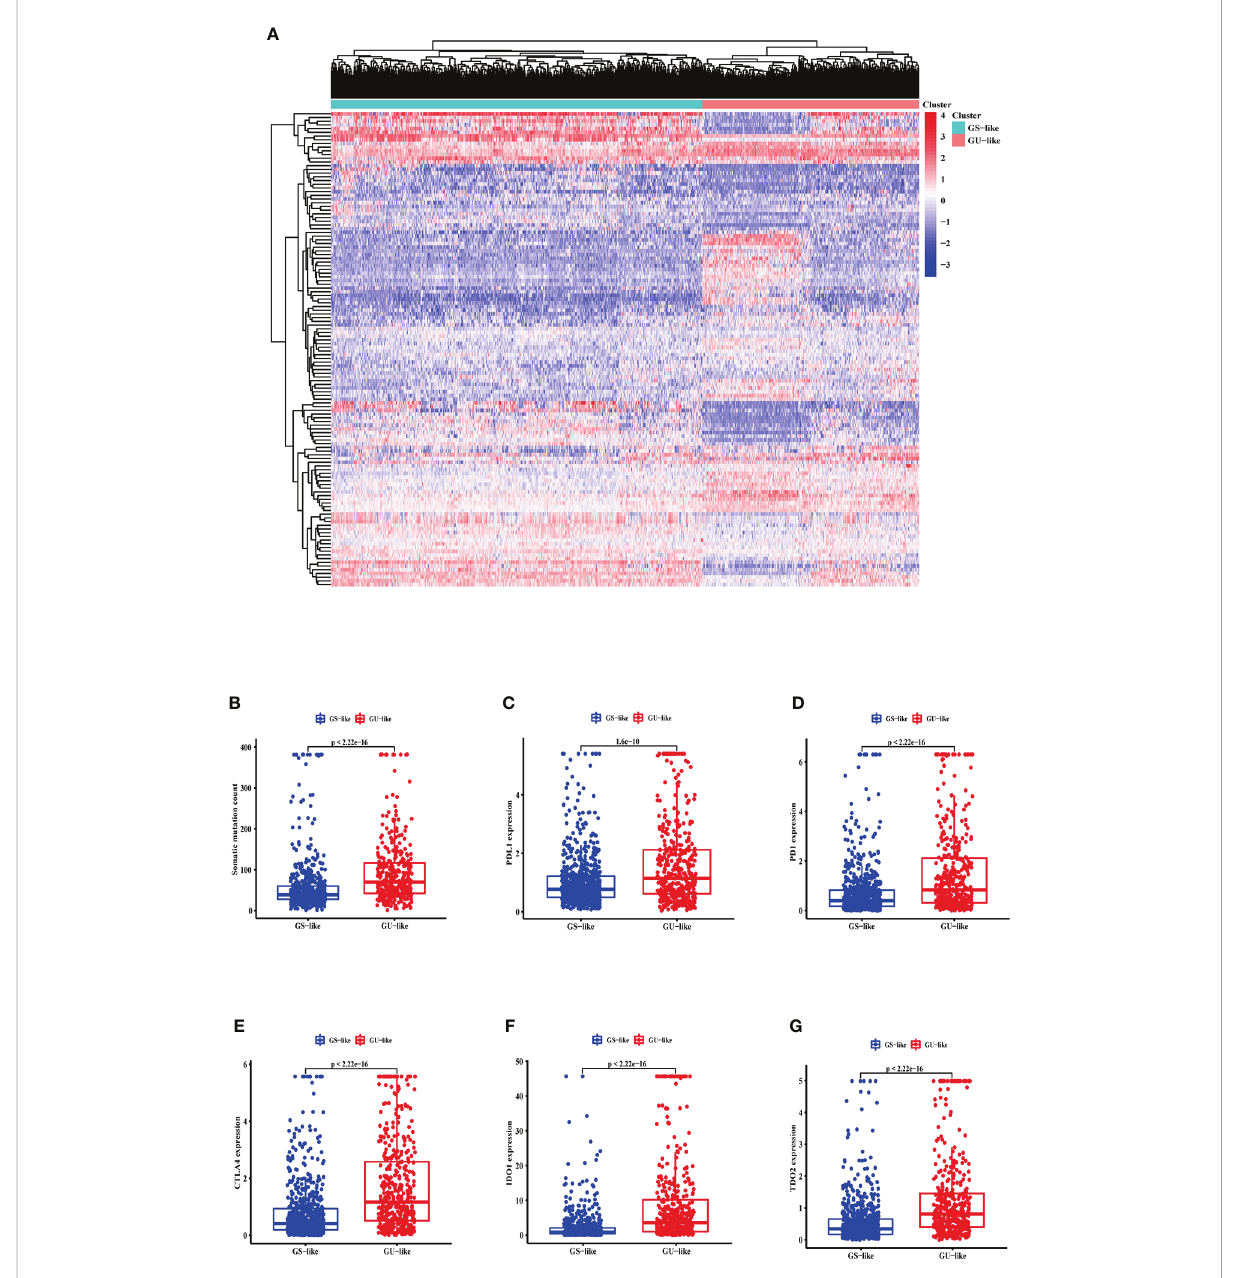
FIGURE 2 The somatic mutations and the expression level of some pivotal immune checkpoints in the GS-like and GU-like group. (A) Unsupervised clustering of 1,109 breast cancer patients according to the expression levels of 128 genomic instability-related lncRNAs. The right red cluster is the GU-like group, and the left blue cluster is the GS-like group. (B) Boxplots of somatic cumulative mutations in the GU-like and GS-like groups. The somatic mutation counts in the GU-like group are higher than in the GS-like group. The expression level of PDL1 (C) , PD1 (D) , CTLA4 (E) , IDO1 (F) , and TDO2 (G) in the GU-like group are higher than the GS-like group. Horizontal lines are median values. GS, genomically stable group; GU, genomically unstable